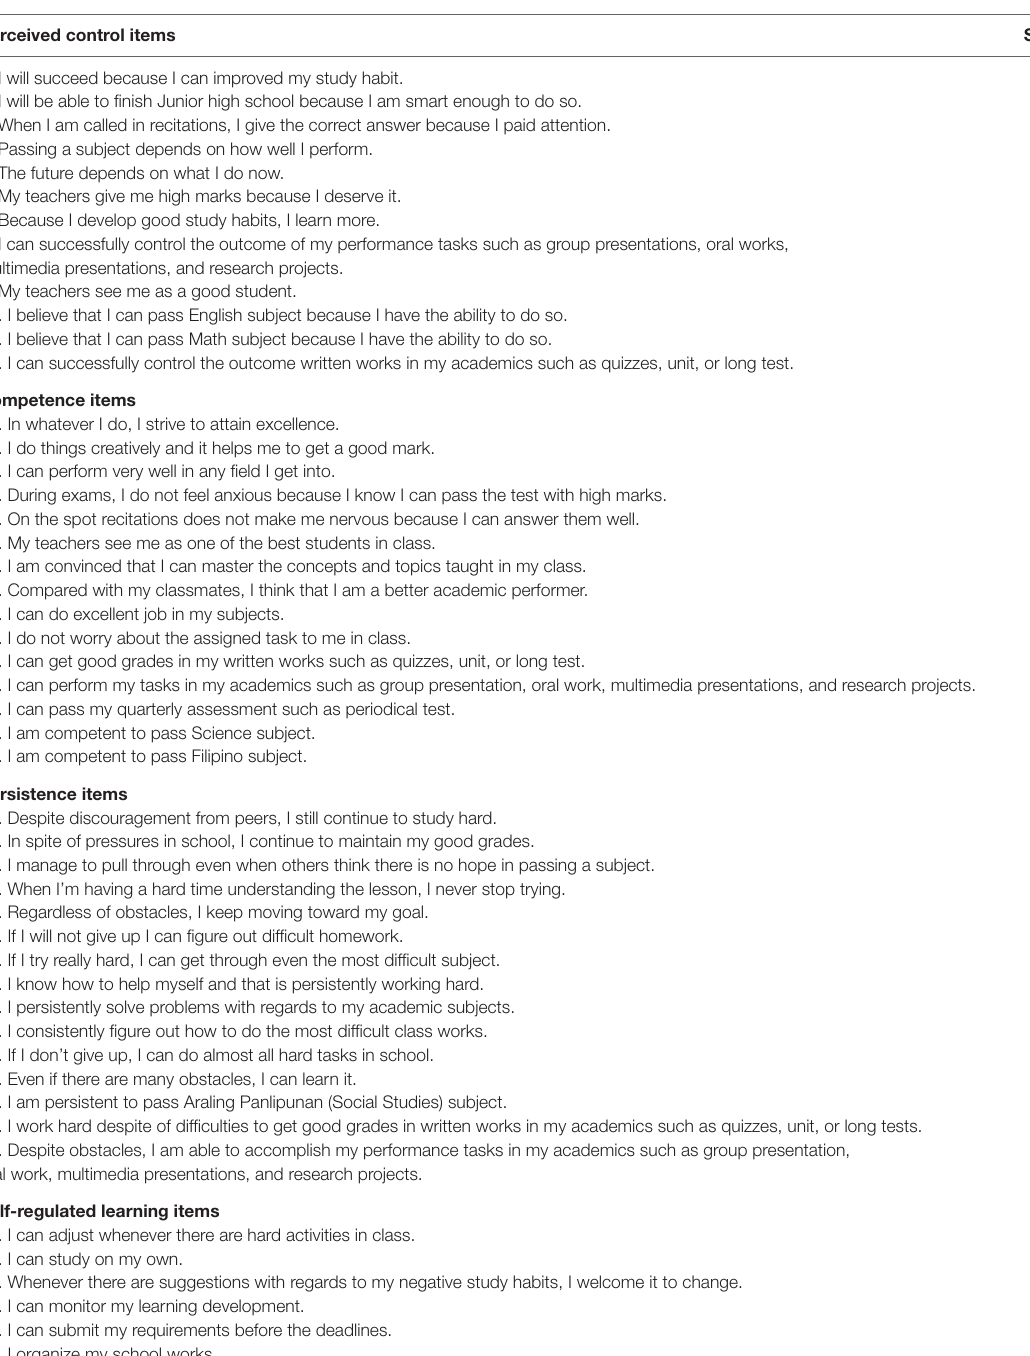
TaBle a1 | Academic Self-efficacy Scale for Filipino Junior High School Students Final